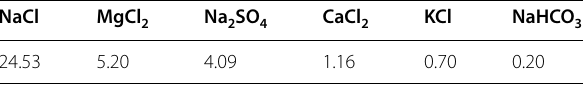
Table 2 Chemical composition of artificial simulated seawater (kg/m 3